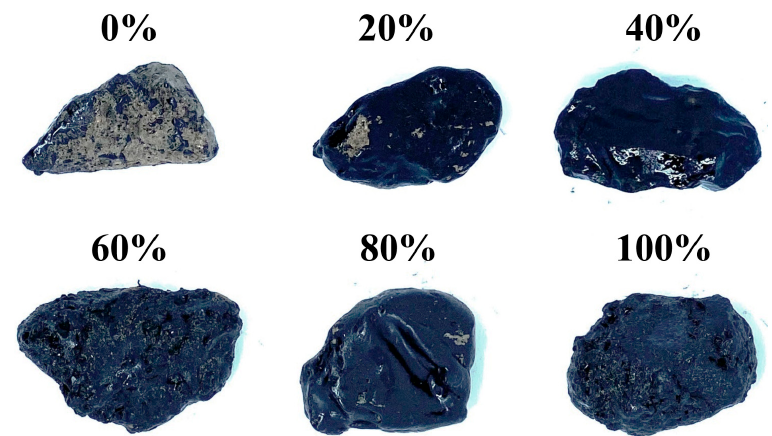
Figure 5. Aggregates with P-AM after boiling